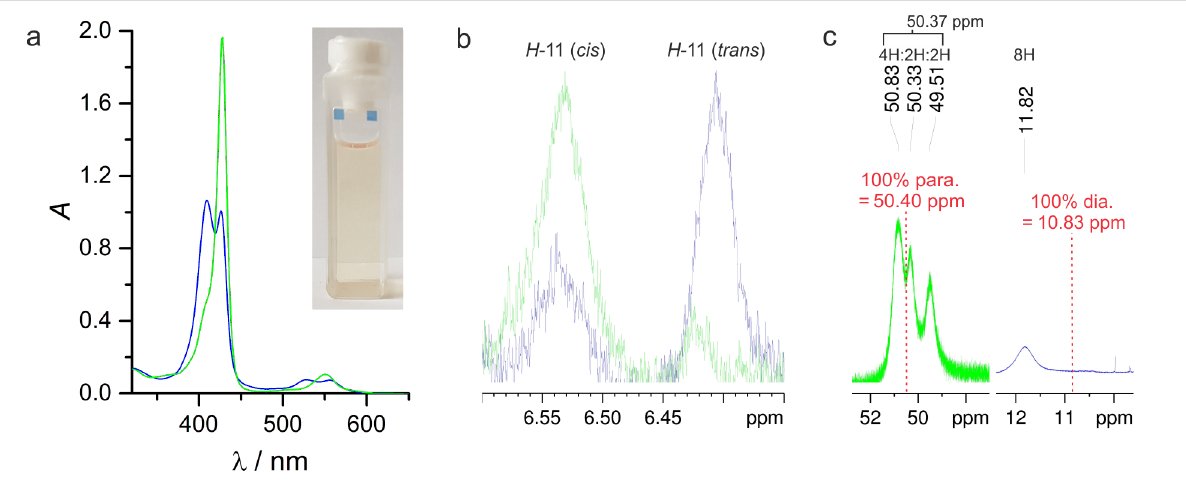
Figure 3: a) UV–vis cuvette with a solution of porphyrin 1 (13.1 µM in THF) and the corresponding UV–vis spectra at 25 °C in the PSS at 530 nm (green) and 435 nm (blue). b) Signals of proton H-11 ( 1 H NMR, 600 MHz, THF- d 8 , 318 K), which are an indicator for the cis–trans isomerization of the azo unit of porphyrin 1 , in the PSS at 530 nm (green) and 435 nm (violet-blue). The signal at 6.54 ppm belongs to the cis species while the signal at 6.41 represents the trans isomer. c) 1 H NMR signals ( 1 H NMR, 600 MHz, THF- d 8 , 300 K) of the pyrrole protons in the PSS at 530 nm and 435 nm. Coordination/decoordination is fast on the NMR timescale and signal averages for the pyrrole protons are observed. 50.40 ppm corresponds to 100% coordinated (paramagnetic) Ni-porphyrin and 10.83 ppm is the chemical shift of the pure decoordinated (diamagnetic) system. The signals are broad because of paramagnetic line broadening of the coordinated species and fast ligand